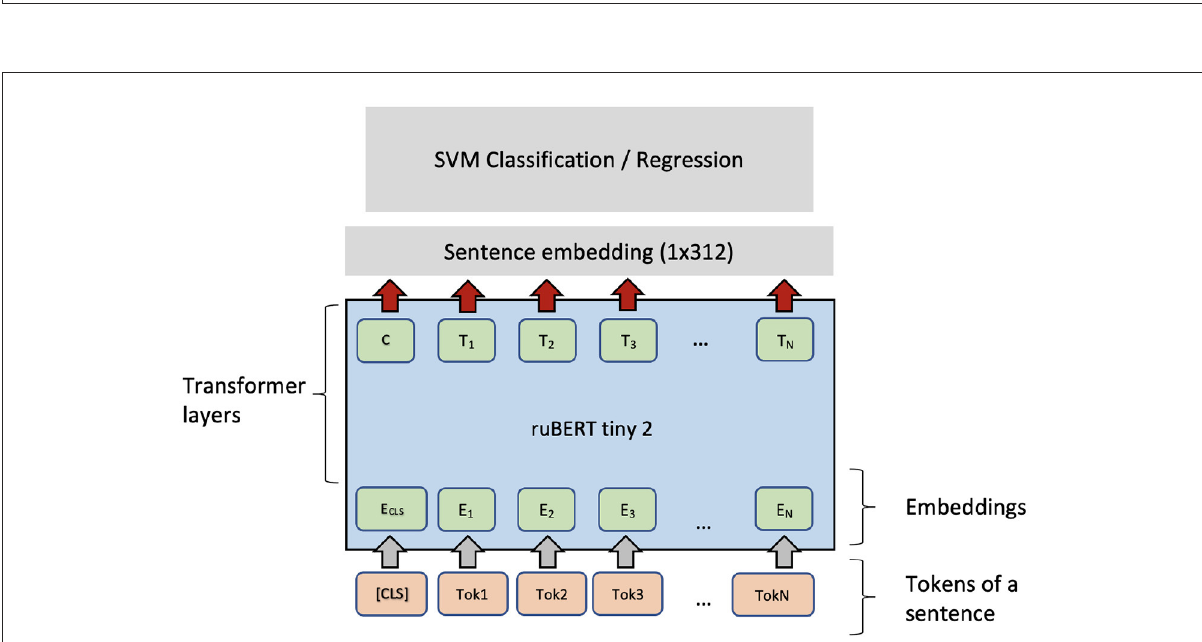
FIGURE4 SVM + ruBERT-tiny2 architecture for single sentence complexity